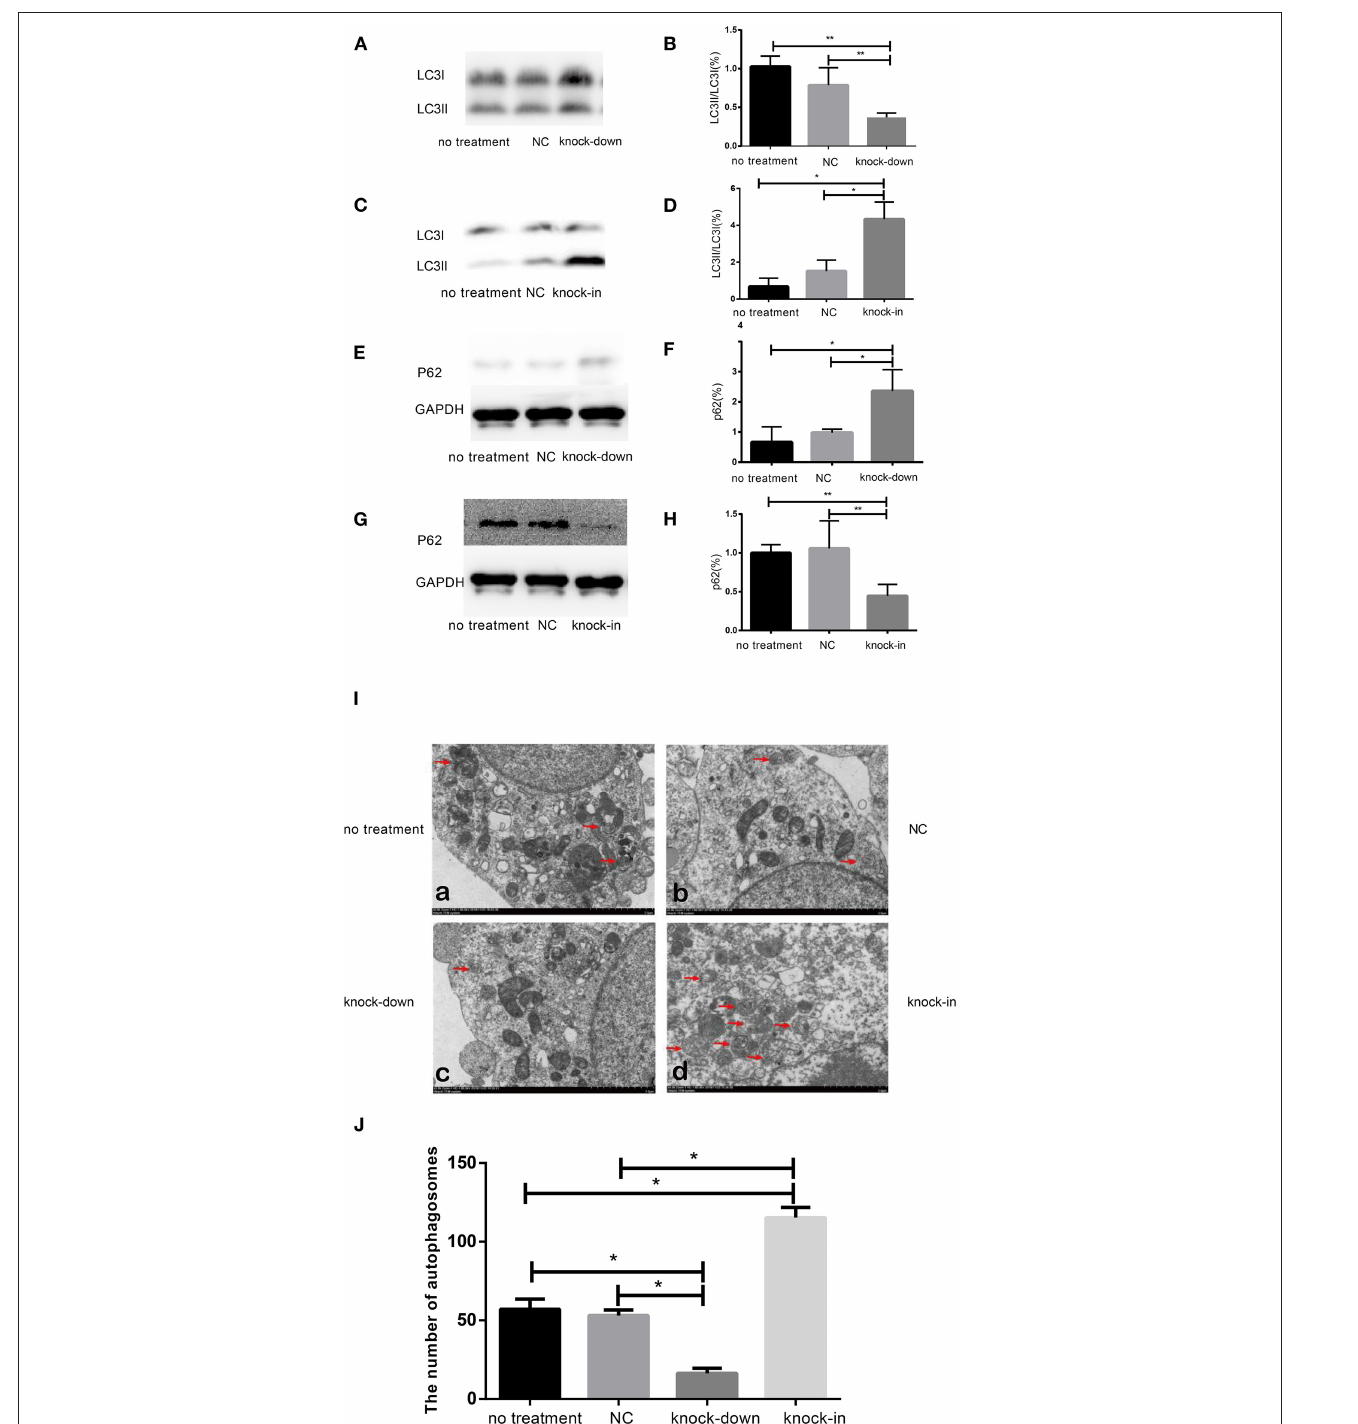
FIGURE 3 | DHCR24 knock-down obviously induced the inhibition of autophagy in SH-SY5Y cells. (A,B,E,F) Representative western blots of LC3 and p62 from DHCR24 knock-down SH-SY5Y cells. (C,D,G,H) Representative western blots of LC3 and p62 from DHCR24 knock-in SH-SY5Y cells. (I) Transmission electron microscopy showed the autophagosomes (red arrow). Scale bar = 2.0 µ m. (J) Quantitation analyses of autophagosomes for (I) . All the data are presented as mean ± SD of at least three individual experiments ( n = 3).* P < 0.05, ** P < 0.01; vs. the no treatment and NC group ( Figures 2I , Q , 3E share one loading control; Figures 2K , S , 3G share one loading